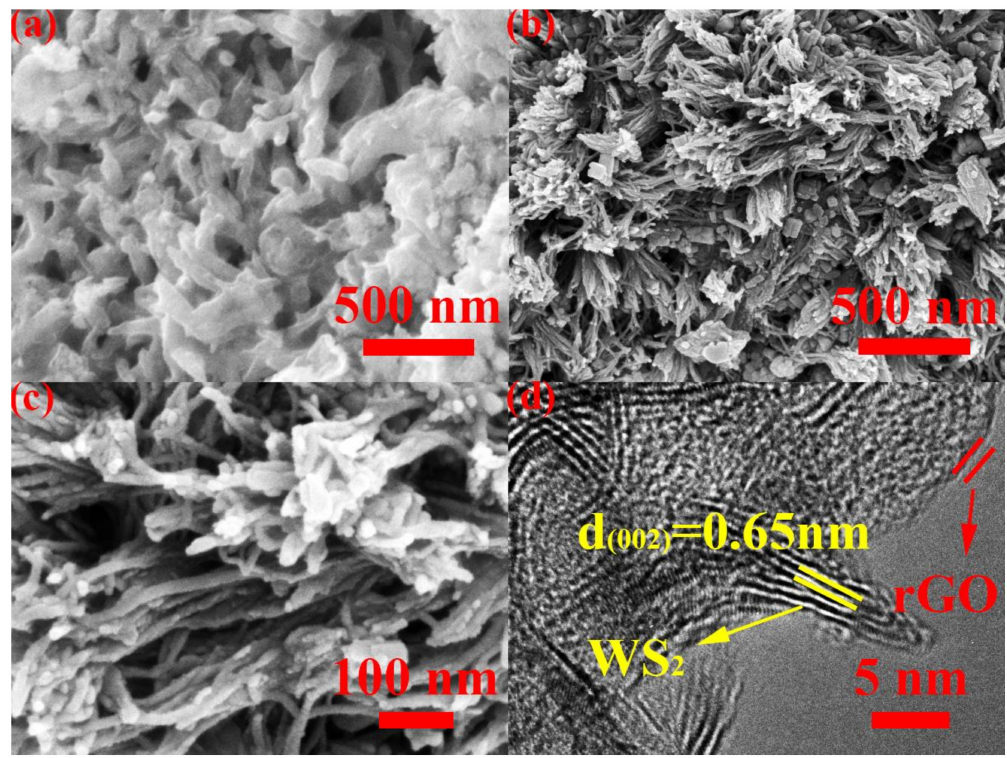
Figure 1. ( a ) SEM images of bare WS 2 and ( b – c ) SEM, ( d ) TEM images of WS 2 /rGO composites.